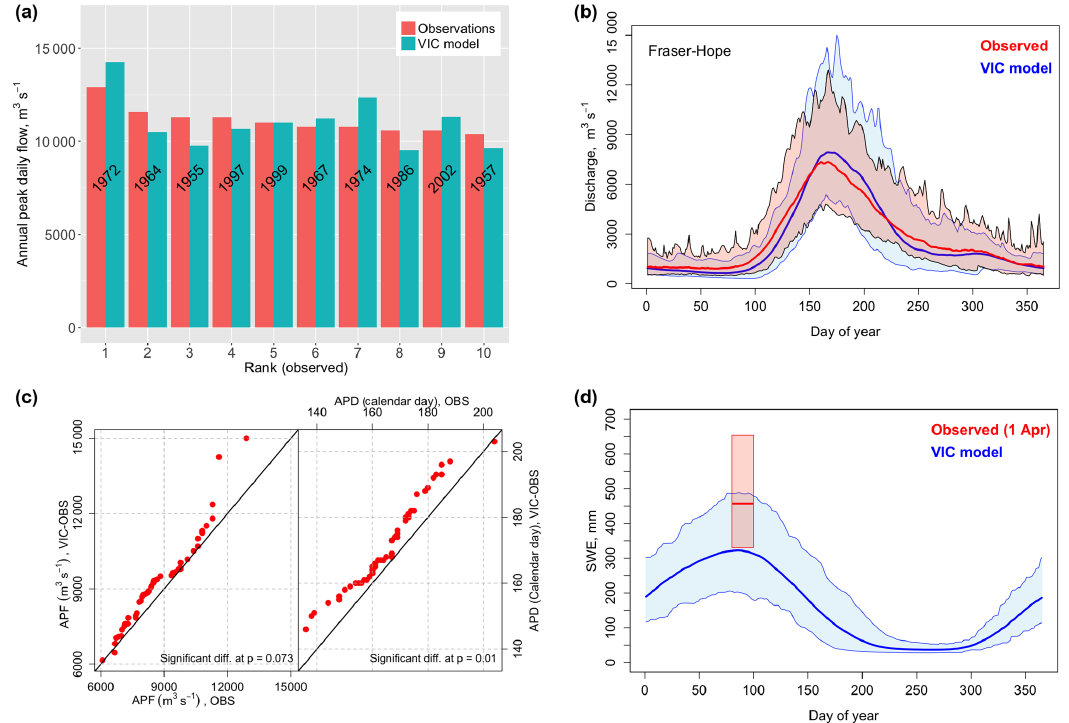
Figure 5. (a) Annual peak daily streamflow (APF) magnitude in observations (red) and in the VIC simulation (blue) at Fraser-Hope, ranked by observed values over 1955–2004. (b) Annual cycle of daily streamflow in observations (red) and VIC simulation (blue) over 1955–2004 at Fraser-Hope. (c) Quantile plots of VIC-simulated versus observed APF and APD at Fraser-Hope. Differences between the respective distributions are assessed using a permutation test with 10 4 resamples; the resulting p -values are indicated in each sub-panel. (d) 1 April observed SWE (red) compared with annual cycle of SWE from VIC, both averaged over the FRB for 1956–2006. Heavy curves in (b) and (d) show the multi-year mean, while shaded areas show the interannual